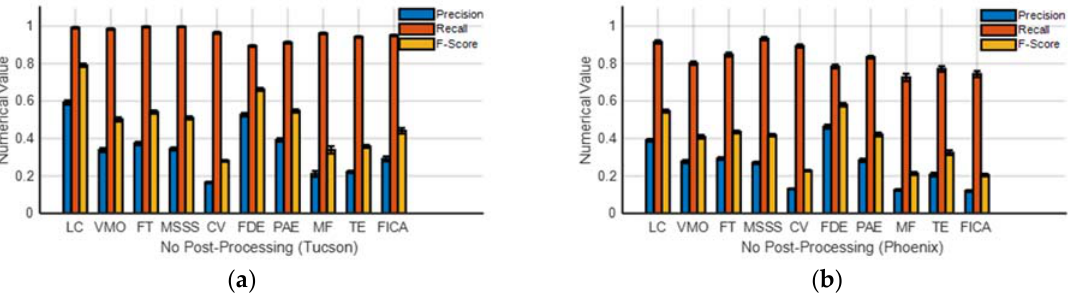
Figure 2. Precision, Recall and F ‐ score of ten detection algorithms for ( a ) Tucson dataset and ( b ) Phoenix dataset.